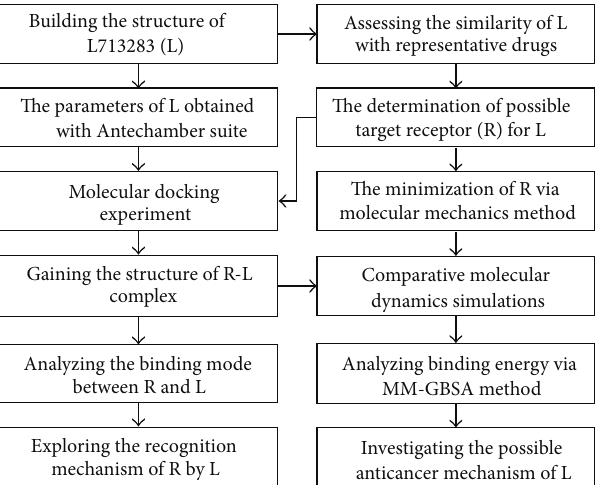
Figure 2: Protocol for the determination of drug target and the investigation of the possible anticancer mechanism for L713283